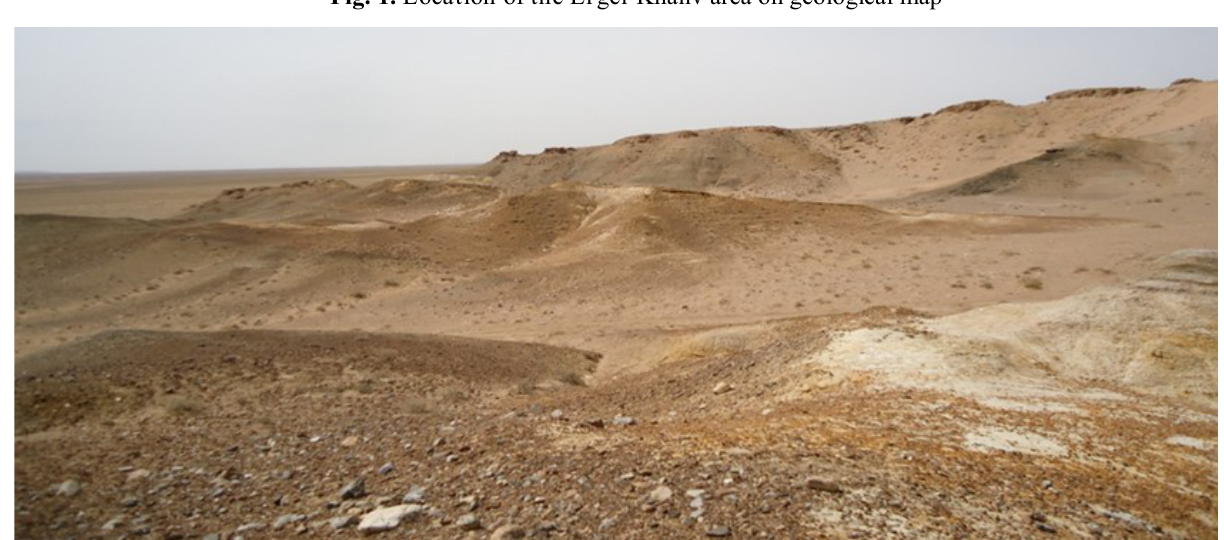
Fig. 2. Typical view of landscape and sedimentary outcrops in the Ergel-Khaliv